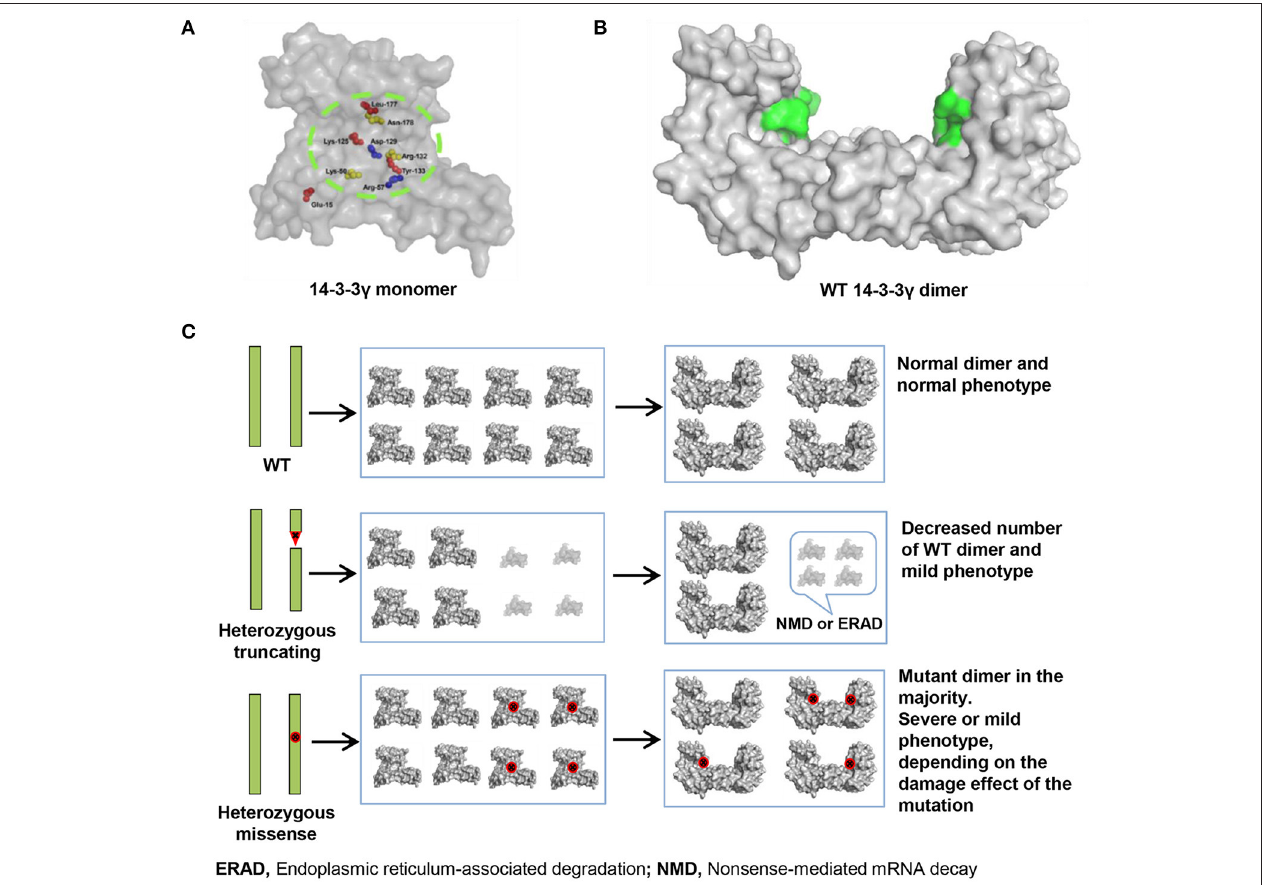
FIGURE 3 | 14-3-3 γ dimer forming and its association with phenotypical variation. (A) A front view of 14-3-3 γ monomer shows the location of the missense mutations. (B) A lateral view of 14-3-3 γ dimer. The peptide-binding grooves are colored as green surface. (C) Difference in the pathogenic mechanism between heterozygous truncating mutation and heterozygous missense mutation. A heterozygous truncating mutation would lead to only decreasing the number of wild-type dimer, whereas a heterozygous missense mutation would lead to majority dimers being mutants. The binding groove with missense mutation is colored red.